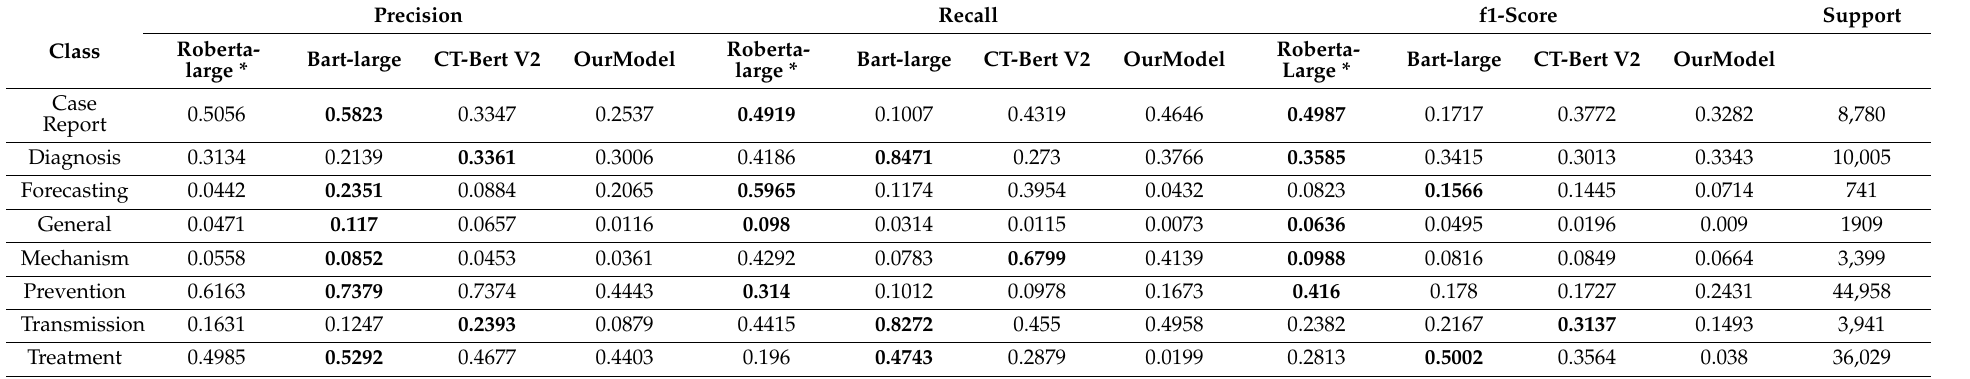
Table 12. Precision, Recall and F1-score for all models. (Bolds indicates highest value on that